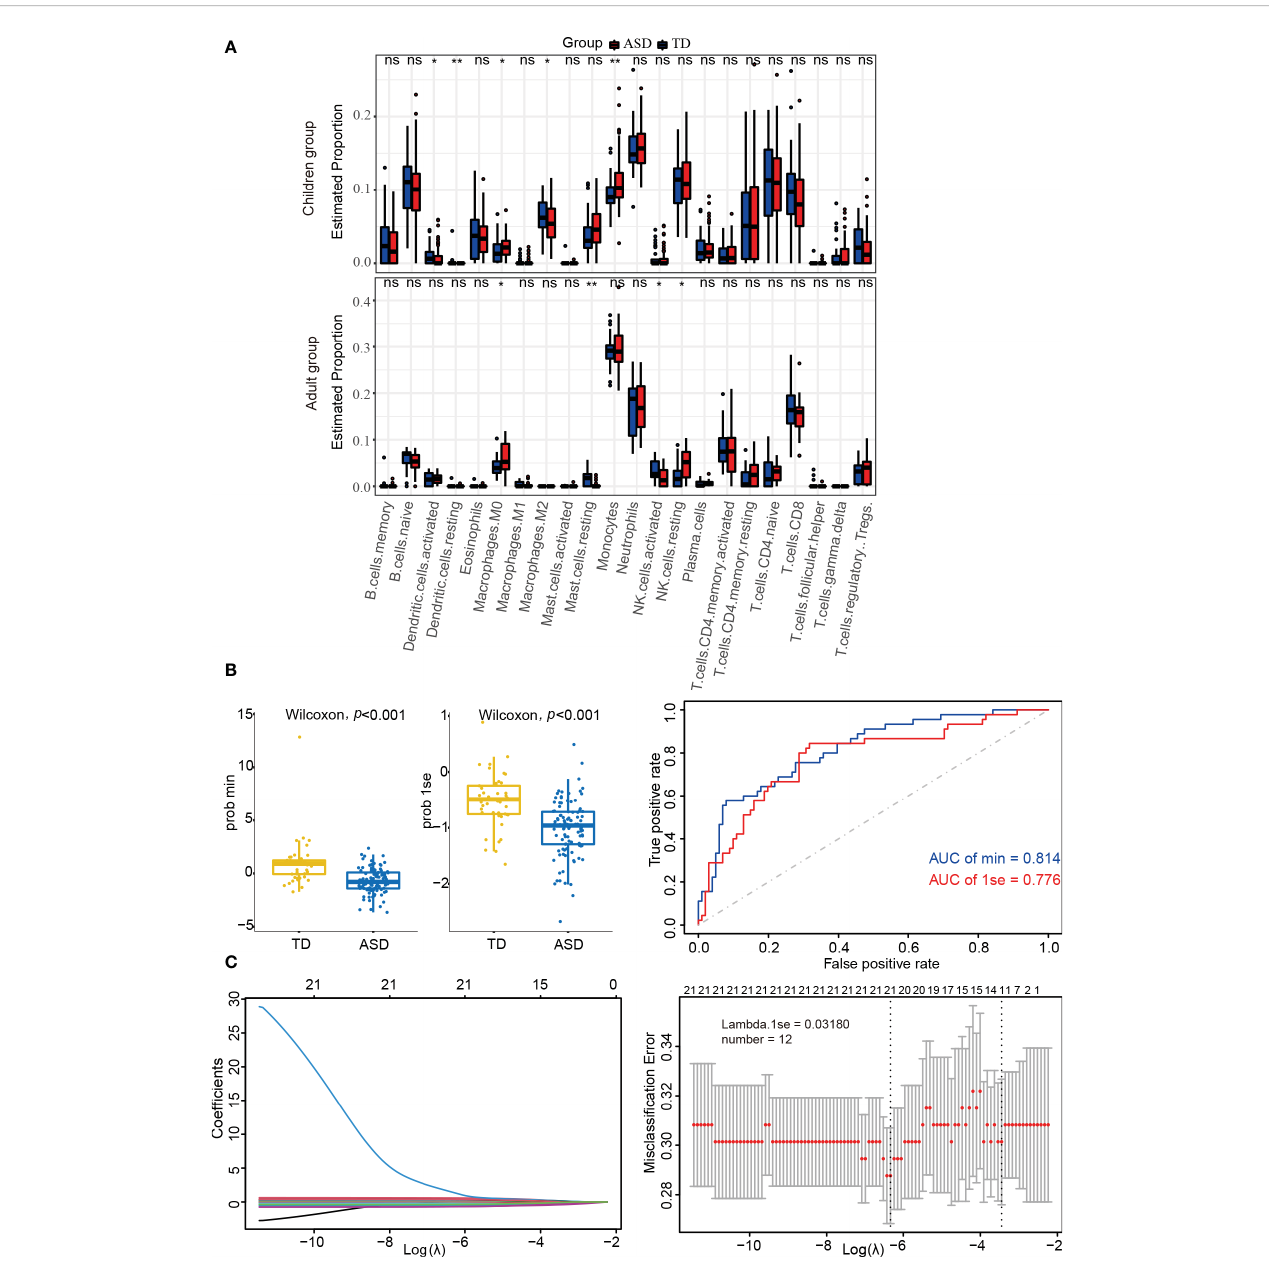
FIGURE 4 Identifying the signi fi cantly different in fi ltrations of immune cells. (A) Kruskal test analysis in children and adults. (B) LASSO regression analysis in children ’ s datasets. (C) Box-plots and ROC curves for assessing classi fi er performance in the LASSO regression model. ns: not signi fi cant; * p < 0.05; ** p <